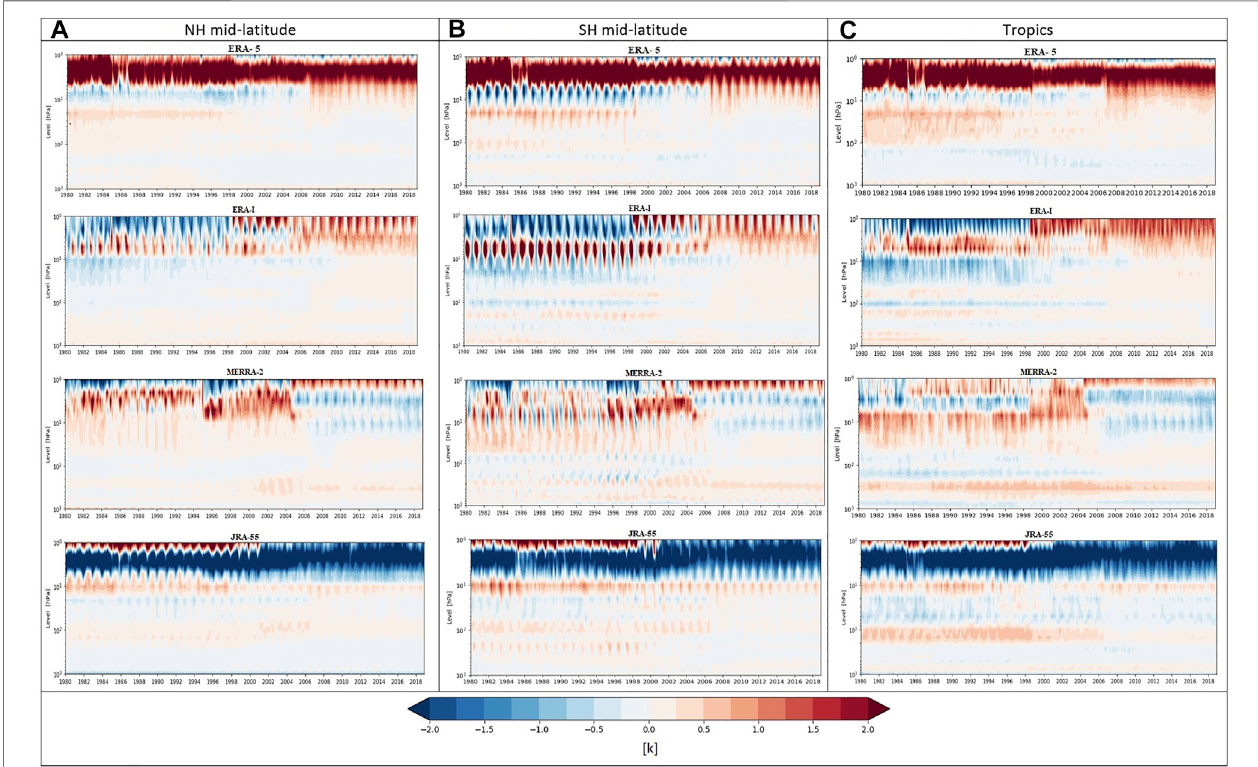
FIGURE2| Temperaturetime-seriesdifferences(inK)betweenreanalysisoftimeseriesandRMMEinthe( A- column)NHmid-latitude,( B -column)SHmid-latitude, and ( C - column) tropics, spanning the period 1980 – 2018.